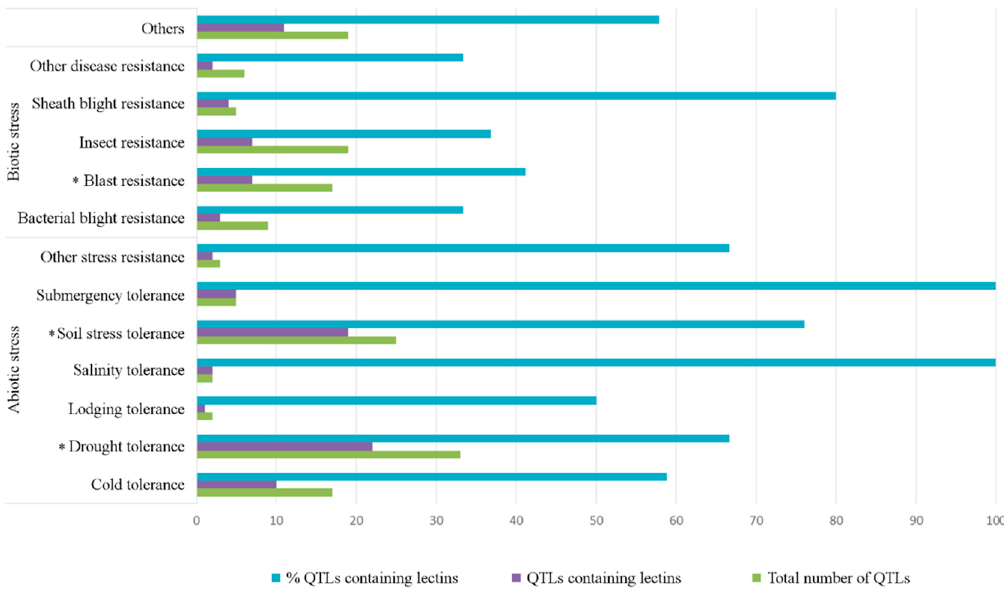
Figure 2. Total number of QTLs for resistance/tolerance, number of QTLs for resistance/tolerance containing lectin sequences, and percentage of QTLs for resistance/tolerance containing lectin sequences. The asterisks refer to statistically significant overrepresentation ( p < 0.001) of lectin sequences in QTLs for the trait(s).